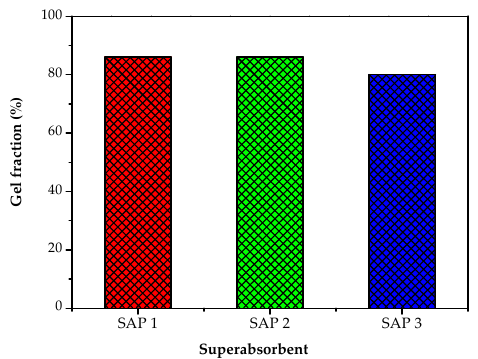
Figure 2. Effect of chitosan concentration in the manufacture of acrylic acid ‐ based superabsorbent on gel fraction.